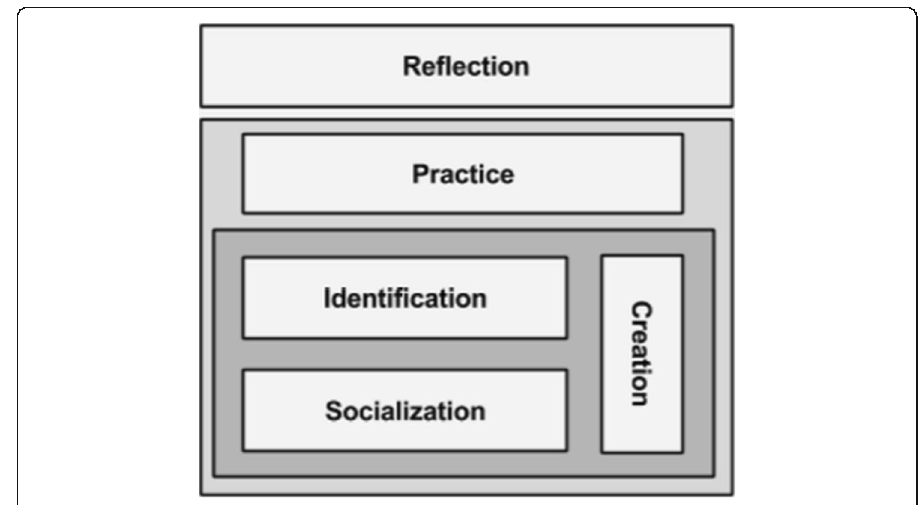
Fig. 5 Five human learning interfaces identified by Koper